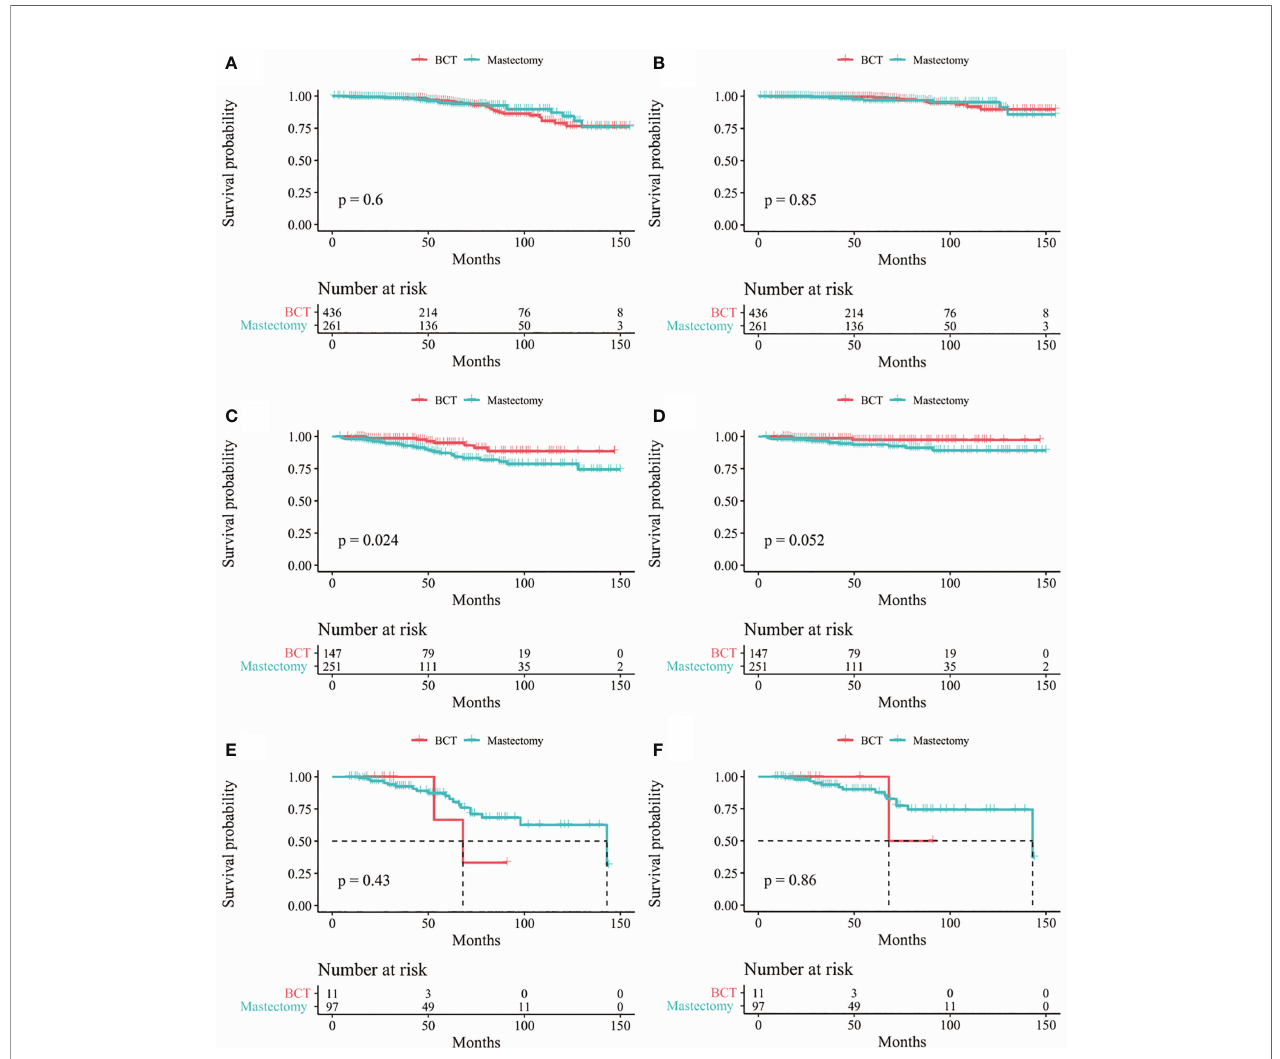
FIGURE 3 | Kaplan-Meier survival curves of subgroup strati fi ed by T stage (A) OS between mastectomy group and BCT group in patients with T1 stage (B) BCSS between mastectomy group and BCT group in patients T1 stage; (C) Os between mastectomy goup and BCT group in patients with T2 stage (D) BCSS between mastectomy group and BCT group in patients with T2 stage (E) Os between mastectomy group and BCT group in patients with T3 stage; (F) BCSS between mastectomy group and BCT group in patients with T3 stage. OS, overall survival; BCSS, breast cancer-speci fi c survival; BCT, breast-conserving